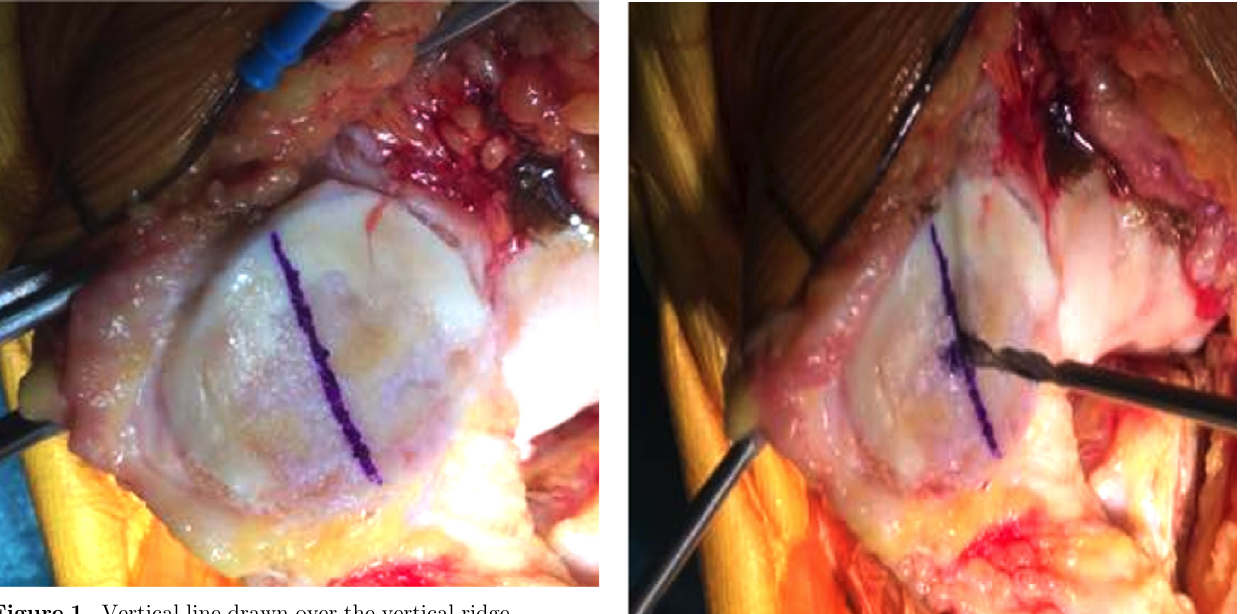
Figure 1. Vertical line drawn over the vertical ridge.